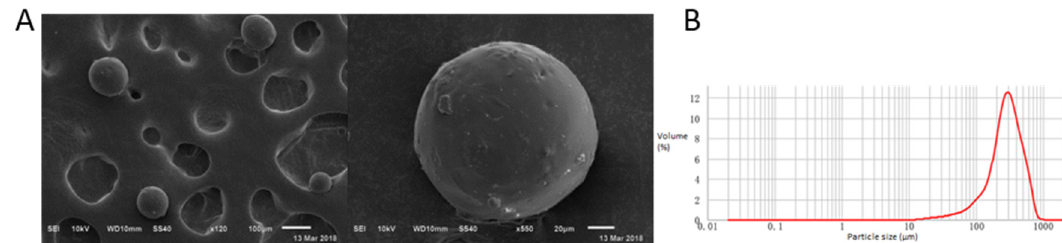
Figure 3. Characterization of microspheres. ( A ) Scanning electron microscope. ( B ) Particle size distribution.